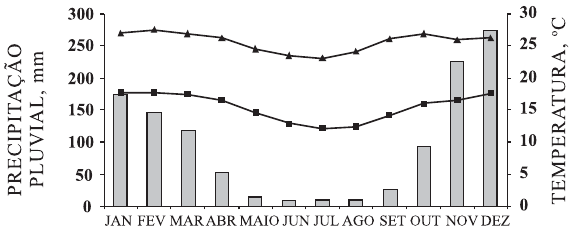
Figura 1. Variação da média mensal de precipitação pluvial e temperatura ( :